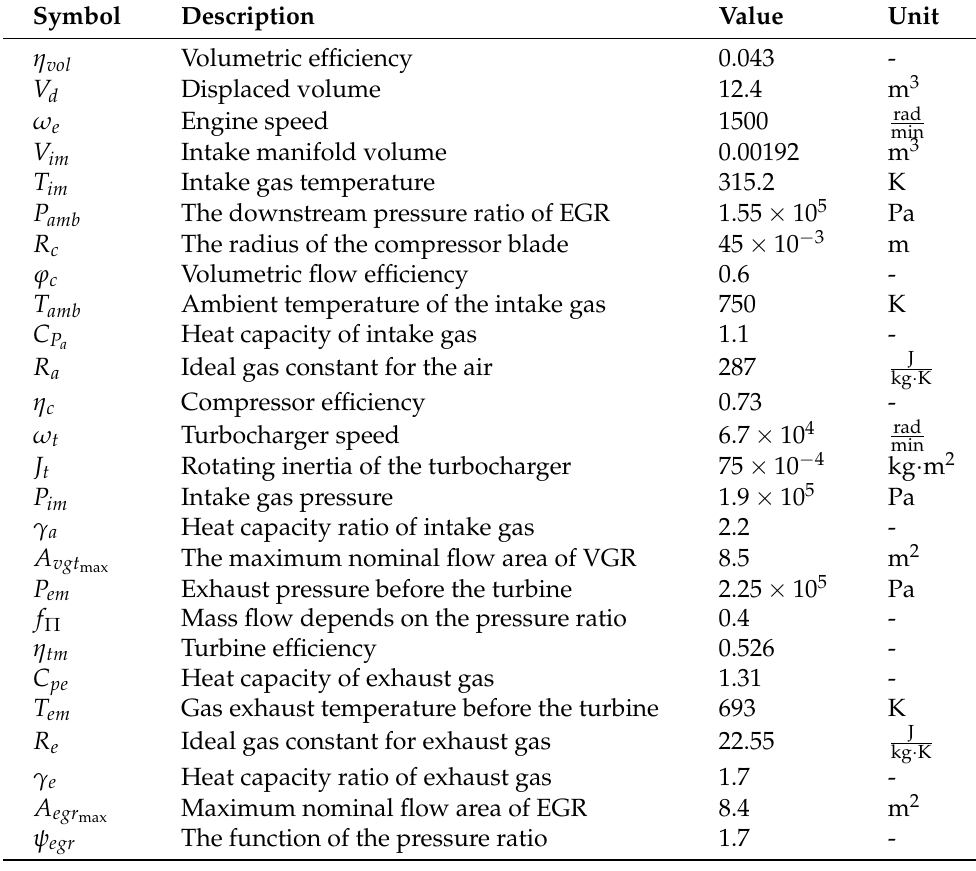
Table 1. The value and description of the real system’s